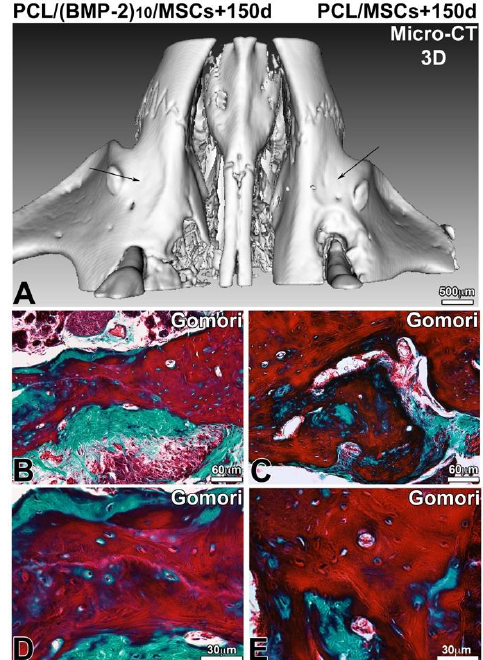
Figure 7. Observation of bone regeneration of the maxillary bone 150 days after implantation of a PCL membrane functionalized with BMP-2 ( A , B , D ) and non-functionalized ( A , C , E ) with hBM-MSCs. A 3D reconstruction ( A ) of frontal and sagittal sections of X-ray microtomography and after microtome cutting and Gomori trichrome staining ( B – E